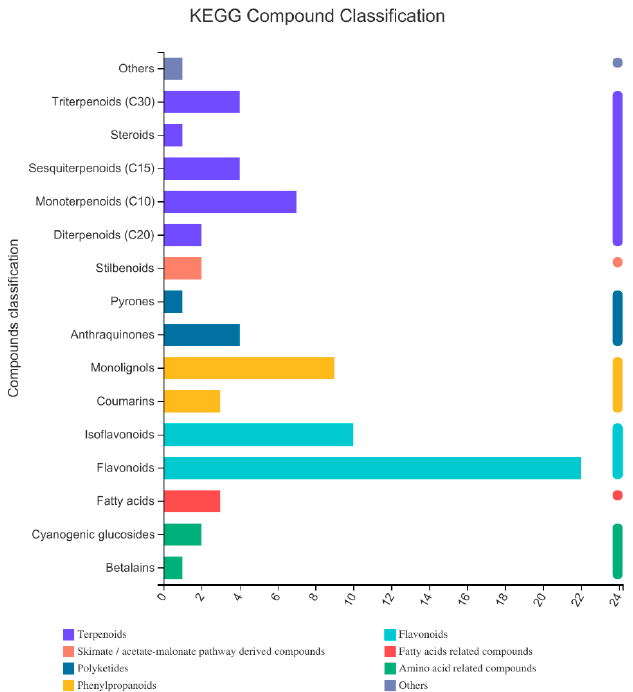
Figure 2. KEGG classification results of compounds. The ordinate is the classification of KEGG compounds, and the abscissa is the number of compounds annotated to this category. The bar’s color indicates that the compound belongs to the primary classification